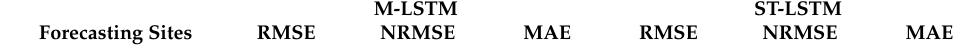
Table 6. Forecasting performance of spatial LSTM compared to univariate and multivariate LSTMs. M-LSTM ST-LSTM Forecasting Sites RMSE NRMSE MAE RMSE NRMSE MAE Composite